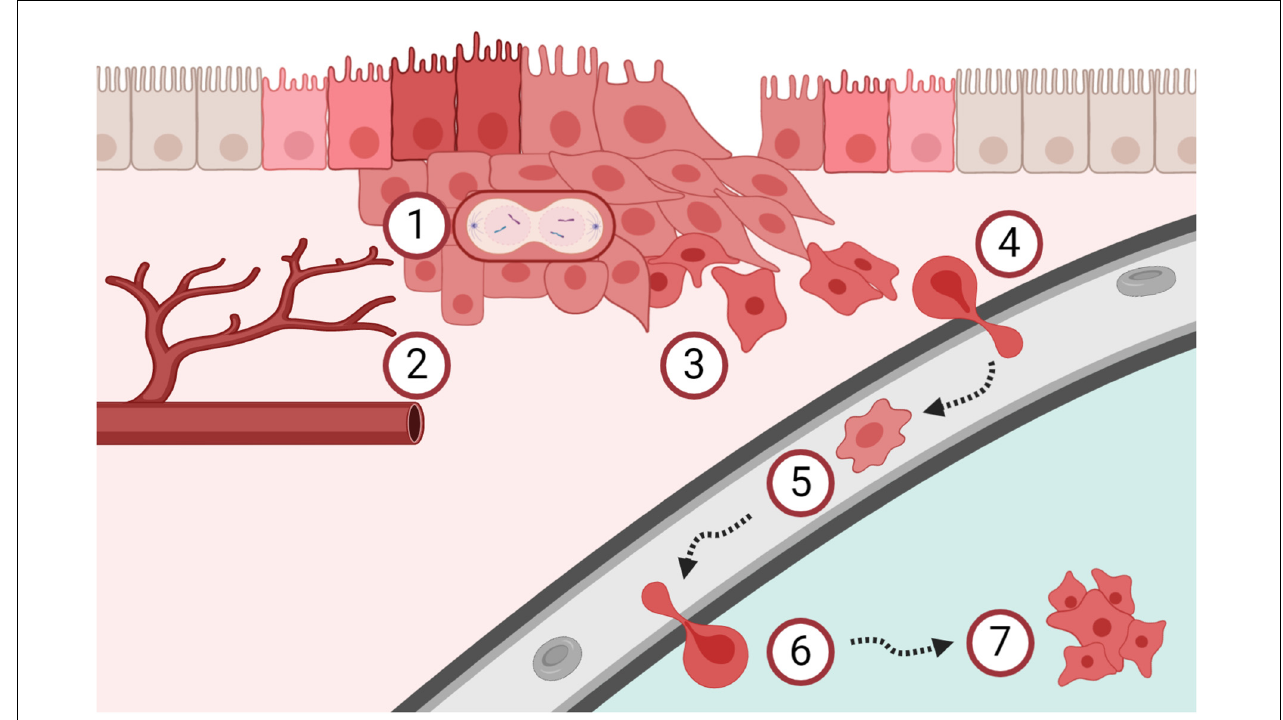
FIGURE 1 | Schematic overview of the metastatic cascade. (1) Cancer cells start to proliferate uncontrolled and (2) tumor angiogenesis is mandatory to support continued tumor growth, already early during carcinogenesis. (3) The process of epithelial-mesenchymal transition increases the migration and invasion capacity of cancer cells. (4) Cancer cells intravasate into the blood circulation and (5) are then called circulating tumor cells (CTCs). CTCs are easily accessible by liquid biopsies and are currently investigated as tool for cancer diagnostics and surveillance. (6) A subpopulation of these CTCs has the potential to extravasate and (7) form metastasis in secondary organs. Clearly, the metastatic process is very complex and many of these steps are interconnected. Please refer to the main text for details and